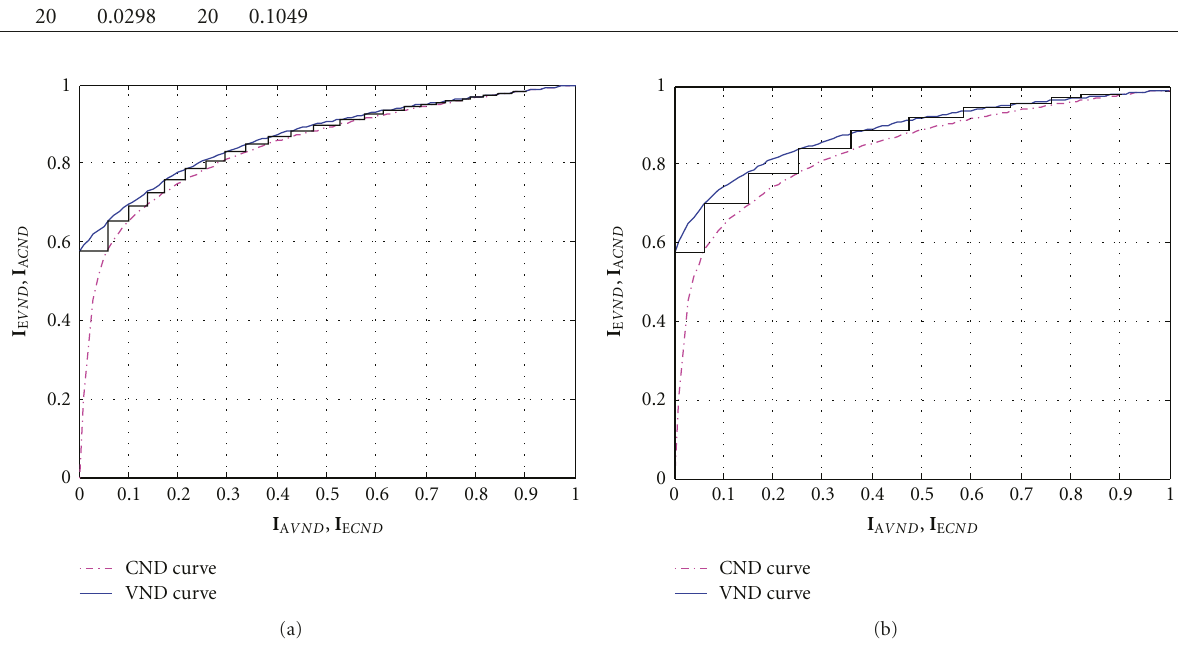
or C t 1 , and (b) C SR S 1 S 2